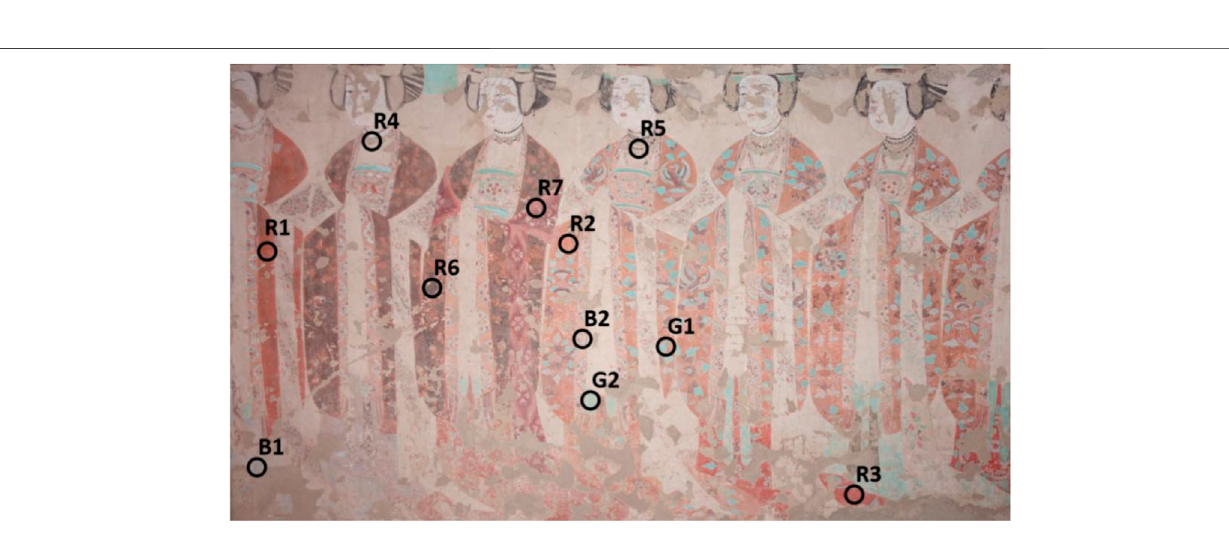
FIGURE 3 | Areas of ancient murals in the south wall of Cave 98 about 2.0 m × 0.9